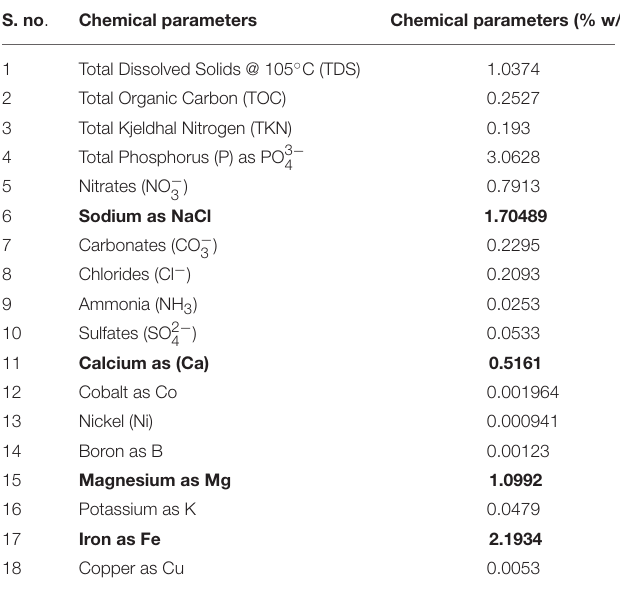
TABLE 1 | Quantification of chemical parameters of Lonar lake sediments (figures in bold shows values of important